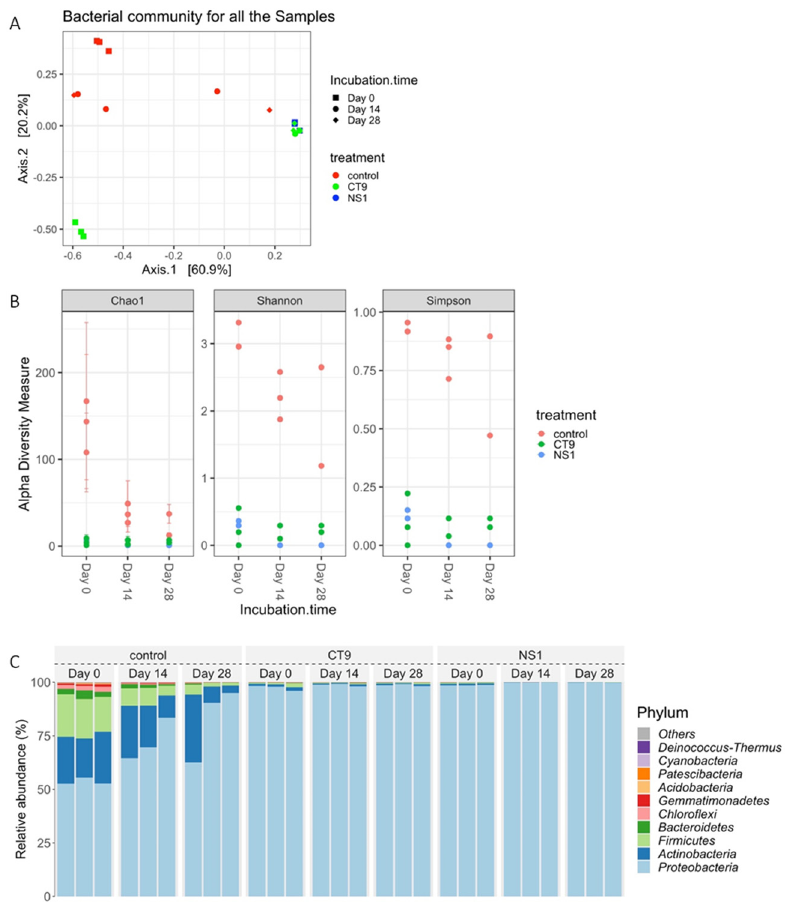
Figure 5. ( A ) PCoA ( B ) alpha diversity indices ( C ) most abundant phyla in the three soil treatments during the 28-day incubation.